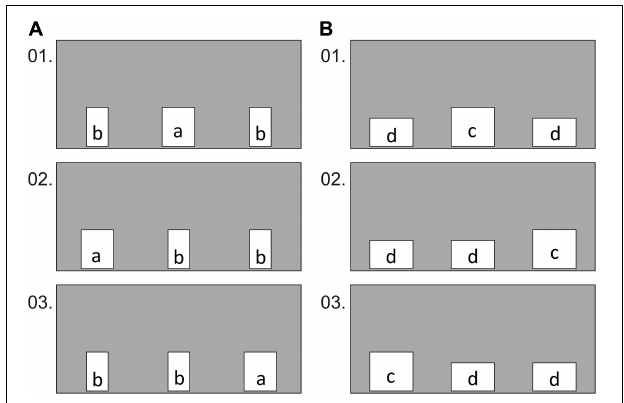
FIGURE 3 | Experiment 1, group 1, test: examples of the first 3 conditions in which the holes were oriented with the long side either vertically (A) or horizontally (B) . Hole sizes: a—15 × 18 cm; b—10 × 18 cm; c—20 × 18 cm; d—20 × 13